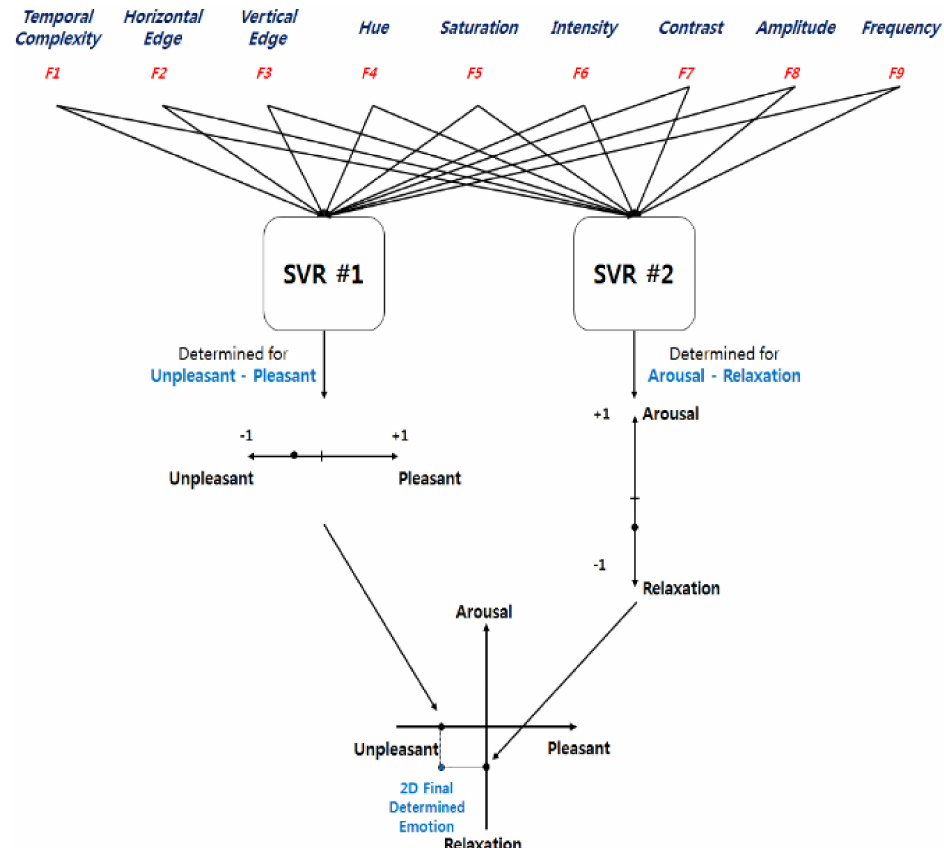
Figure 8. Fully connected dual SVR networks with nine inputs and two outputs.